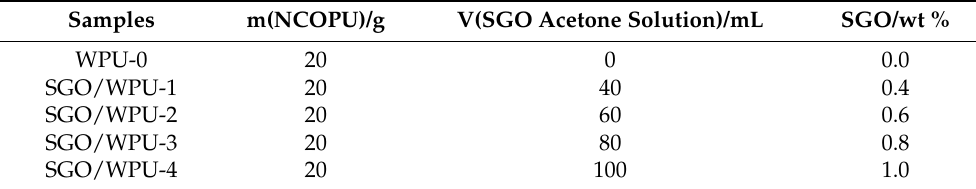
Table 1. Recipes for preparation of different SGO/WPU